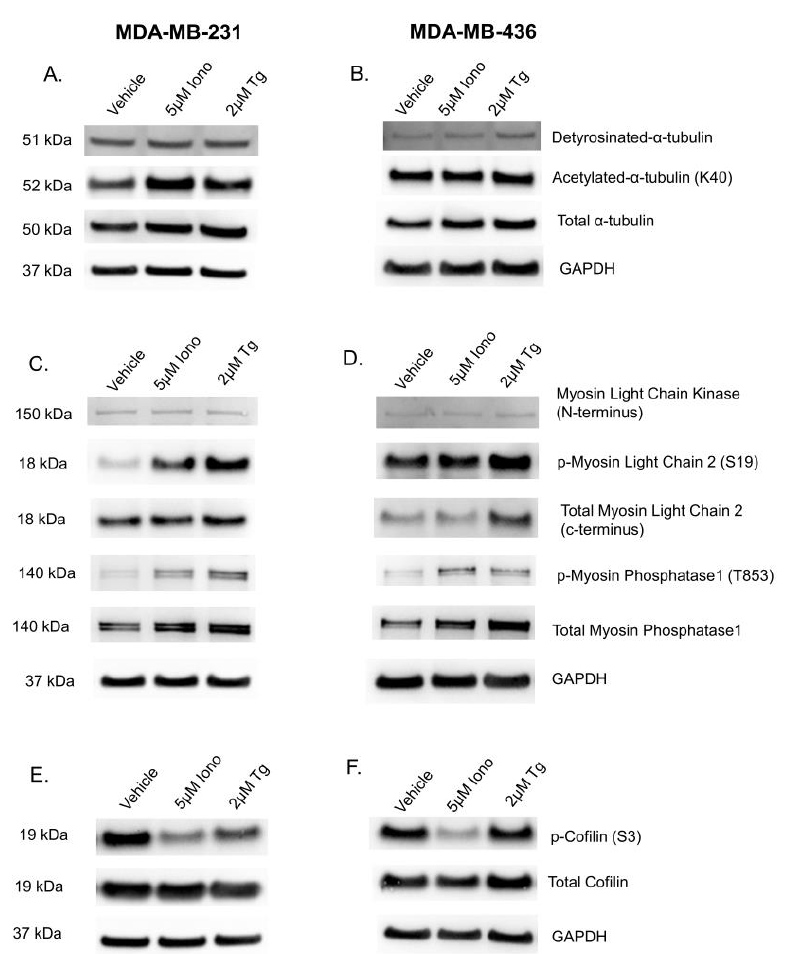
Figure 6. Elevation of cytoplasmic Ca 2+ in MDA − MB − 231 and MDA − MB − 436 cells induces actin cortex contraction and rearrangement. ( A ) Ionomycin or Thapsigargin treatment in MDA-MB-231 cells does not affect microtubule PTMs. ( B ) MDA-MB-436 cells treated with Ionomycin or Thapsigargin does not affect microtubule PTMs. ( C ) Ionomycin or Thapsigargin in MDA-MB-231 cell-induced cytoplasmic Ca 2+ elevation increases the phosphorylation of myosin light chain 2 at serine 19 and of myosin phosphatase1 at threonine 853, indicating cortical actin contraction. ( D ) MDA-MB-436 cells treated with either Ionomycin or Thapsigargin induce cytoplasmic Ca 2+ elevation, which increases phosphorylation of myosin light chain 2 at serine 19 and of myosin phosphatase1 at threonine 853 indicate cortical actin contraction. ( E ) Ca 2+ increases in MDA-MB-231 cells causes a dephosphorylation of cofilin on serine 3, resulting in the activation of cofilin. ( F ) Ionomycin treatment in MDA-MB-436 cells increase cofilin activity through an elevation of cytoplasmic Ca 2+ -mediating dephosphorylation of S3 on cofilin. ( A – F ) Three independent experiments were conducted and representative immunoblot images shown. All original immunoblot images can be found in the supplementary materials.